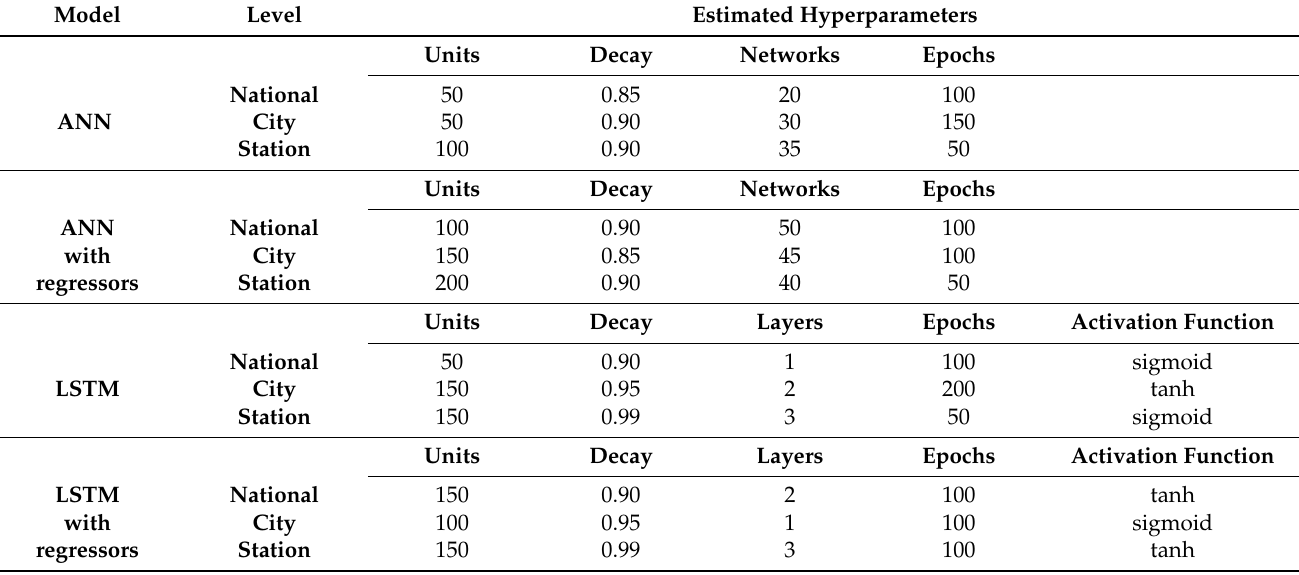
Table 4. Hyperparameters for the machine learning models at three geographical